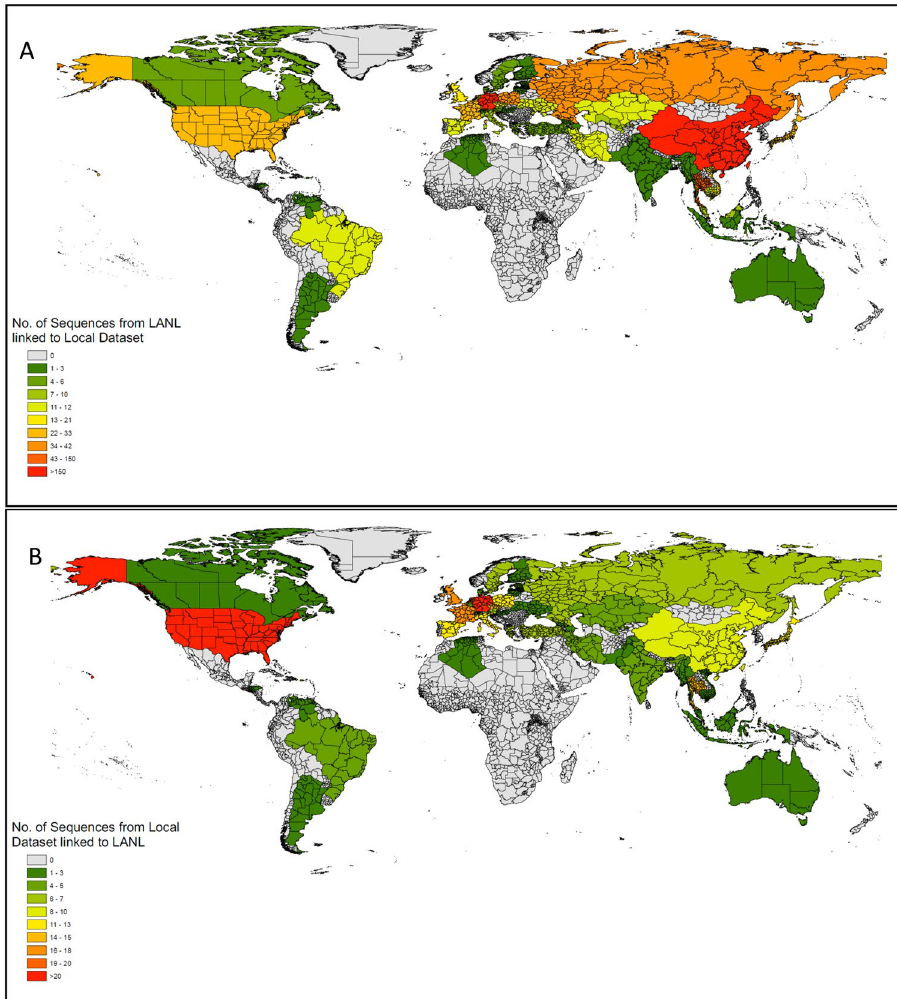
Figure 4. Maps showing linkage with publicly available sequences worldwide. ( A ) Heatmap showing per country number of publicly available sequences linked to this German dataset. ( B ) Heatmap showing per country number of sequences from this German dataset linked to publicly available sequences